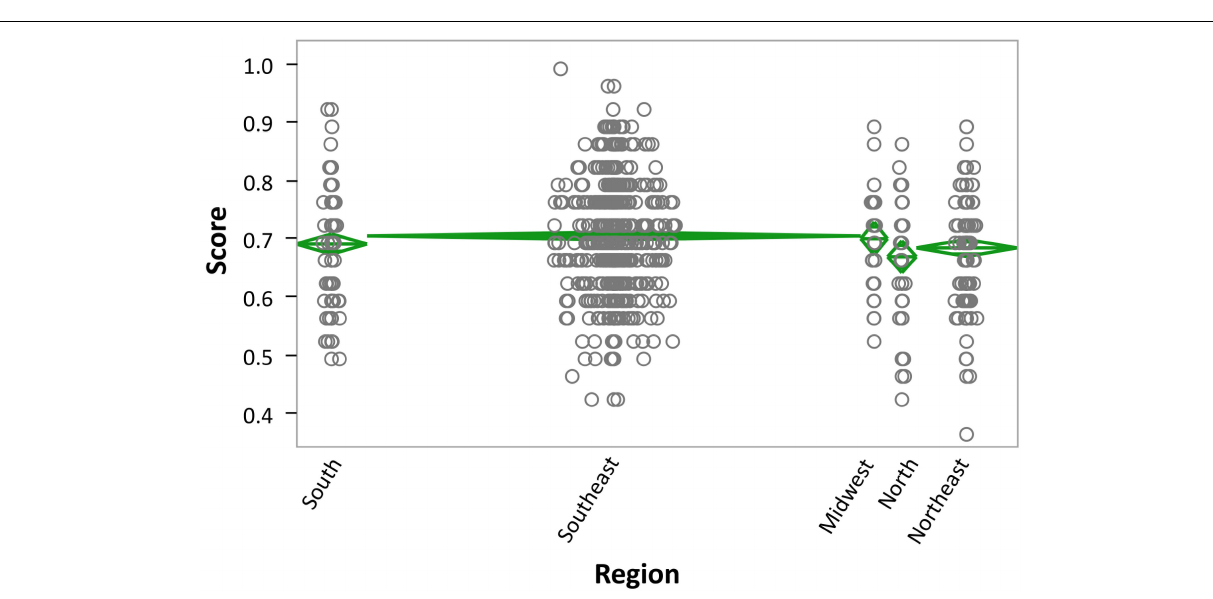
FIGURE 3 | Region × Score. Data are shown in mean diamond graphs, where the width of the diamond is directly proportional to the sample size, and the height corresponds to the variance. No intersection between diamonds implies rejection of the null hypothesis for an α error of 5%. The circle markers represent each participant’s